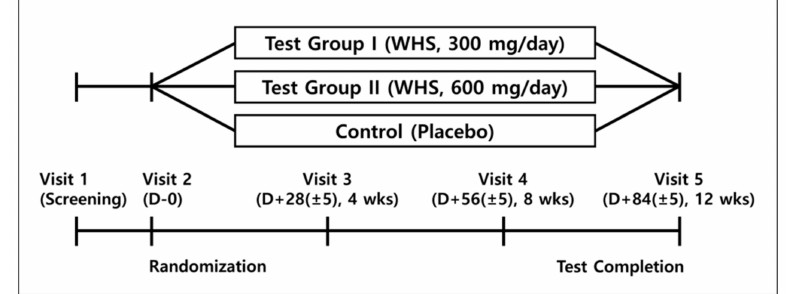
Figure 1. Clinical study